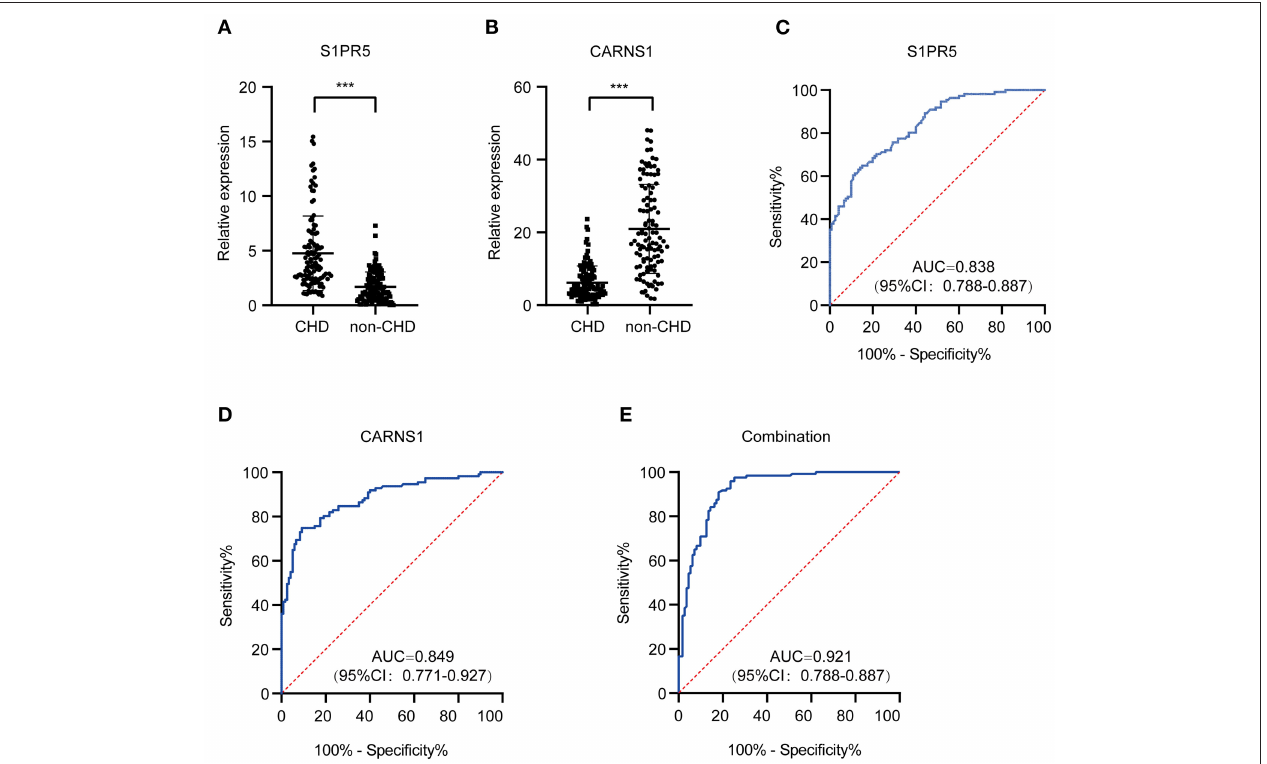
FIGURE 4 | Diagnostic value of plasma exosomal S1PR5 and CARNS1 in CHD patients. qRT-PCR analysis of expression of S1PR5 (A) and CARNS1 (B) in a large sample of CHD patients ( n = 120) and healthy controls ( n = 121). ROC curve analysis of S1PR5 (C) , CARNS1 (D) and combination of S1PR5 and CARNS1 (E) for discrimination of CHD patients ( n = 120) from healthy controls ( n = 121). *** P <